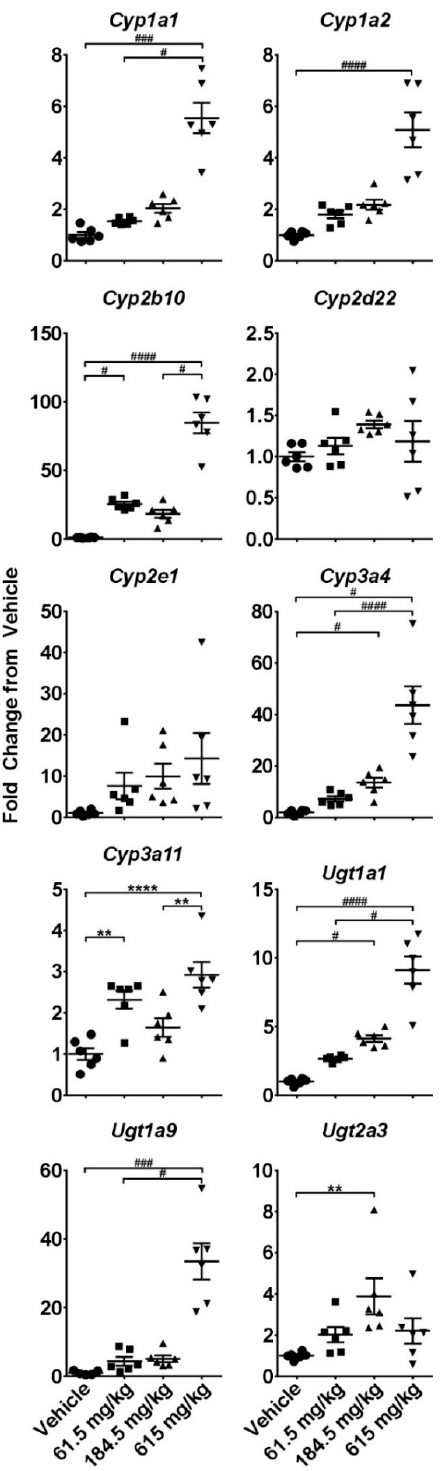
Figure 5. E ff ects of a two-week administration of CBD on intrahepatic expression of cytochrome P450s and UDP-glucuronosyltransferases. Livers were collected 6 h after the last gavage and gene expression was measured using the quantitative real-time (qRT) PCR. * - indicate data analyzed by One-Way ANOVA with Tukey’s post-test, and # indicate non-normal data analyzed with a Kruskal-Wallis and Dunn’s post-hoc test. Data are presented as mean ± SEM fold changed from vehicle ( n = 6), with * or # as p < 0.05; ** or ## as p < 0.01; *** or ### as p < 0.001; and **** or #### as p < 0.0001.